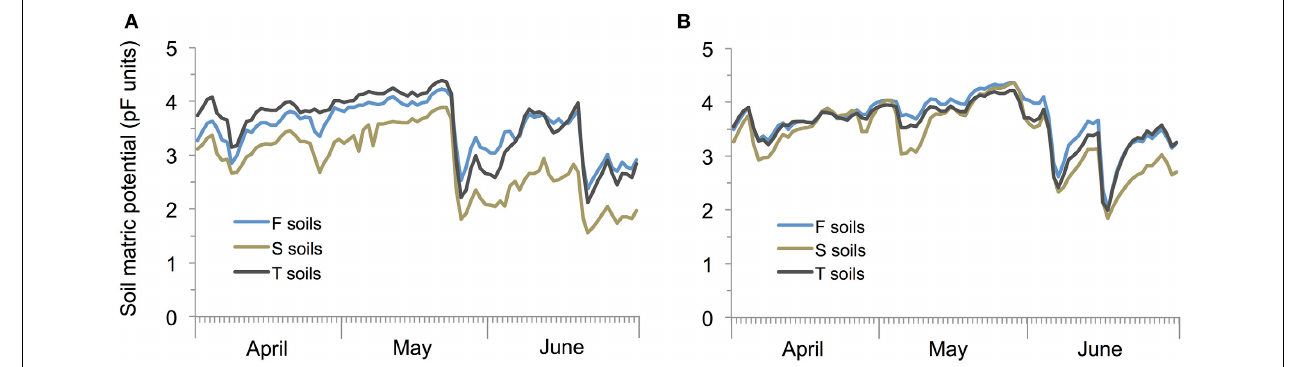
Table 2 | Summary of repeated measurement ANOVA results of the influence of rainfall patterns (current and prognosticated rainfall), soil types (calcaric phaeozem, calcic chernozem, and gleyic phaeozem) and sampling date (April, May, June 2012) on total abundance of arthropods in winter wheat.